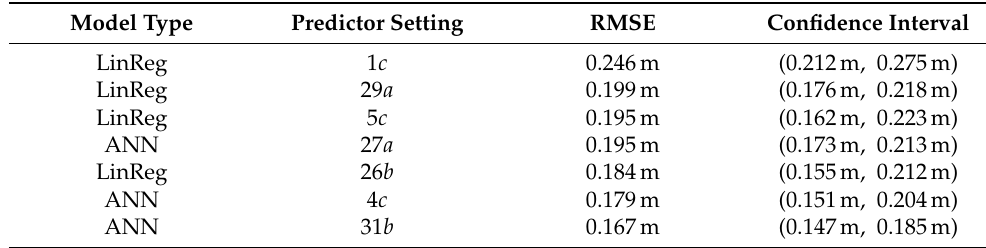
Table 4. RMSE values and appendant confidence intervals obtained with the testing data for selected predictor settings and models. Results for the benchmark model are given in the first row.